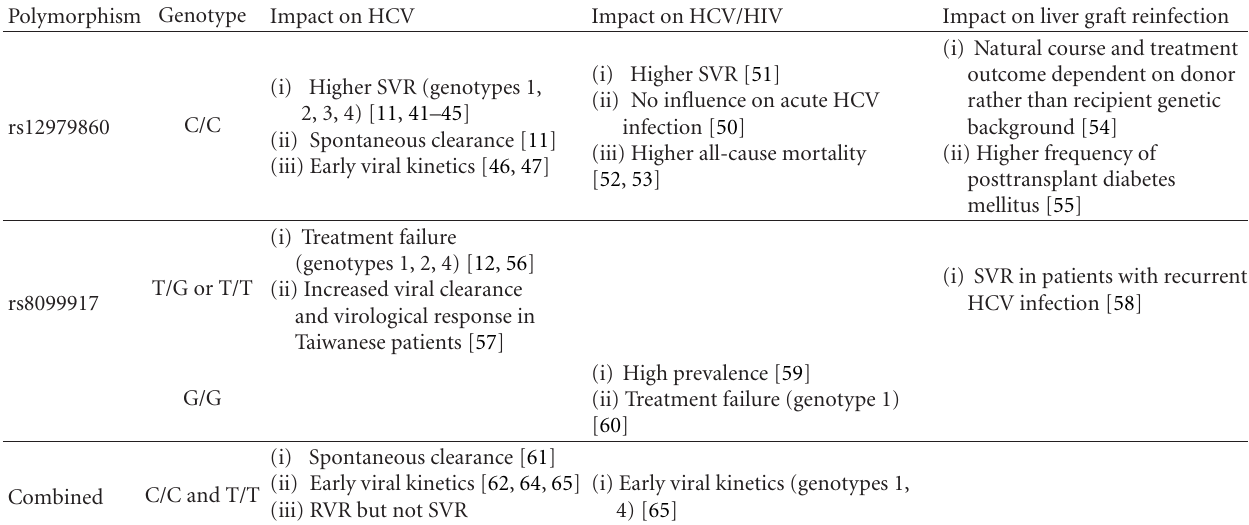
Table 1: Summary of the impact of di ff erent IL28B polymorphisms on HCV infection in several conditions (SVR: sustained virological response; RVR: rapid virological